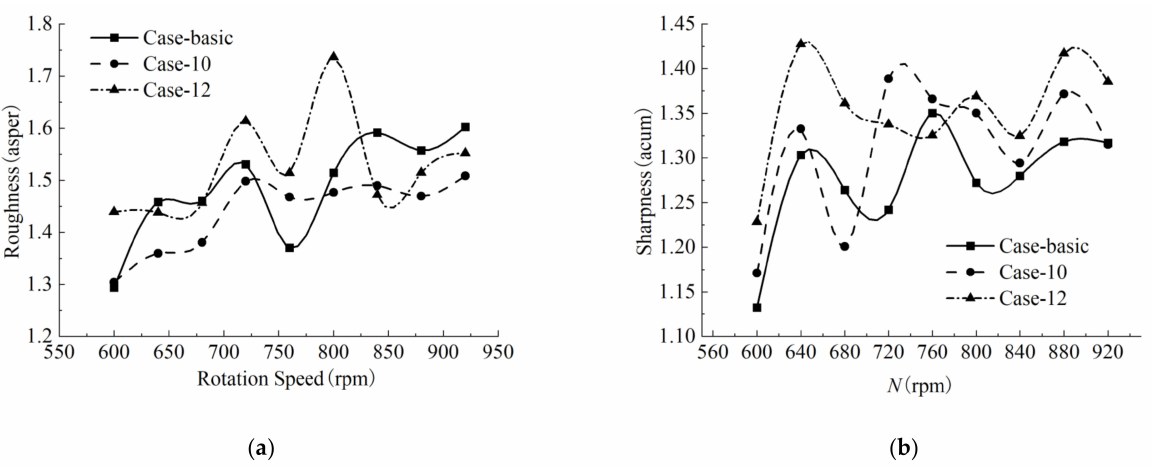
Figure 18. Roughness and sharpness of different blades under different rotation speeds: ( a ) roughness curve and ( b ) sharpness